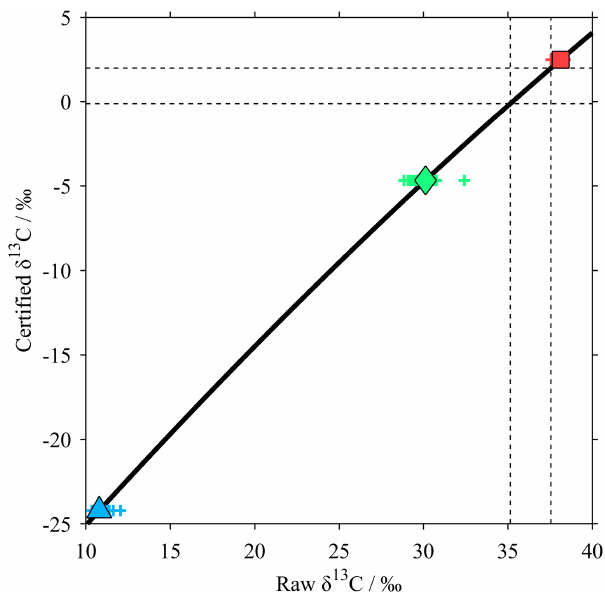
Figure 5. The V-PDB calibration. Mean values for each standard: red square for MAB, green diamond for NA, and blue triangle for CA; results of individual measurements of standards shown as plusses in the same colours as the means. Thick black line shows the calibration curve (Eq. 5); dashed black lines enclose the range of δ 13 C values for the seawater samples and